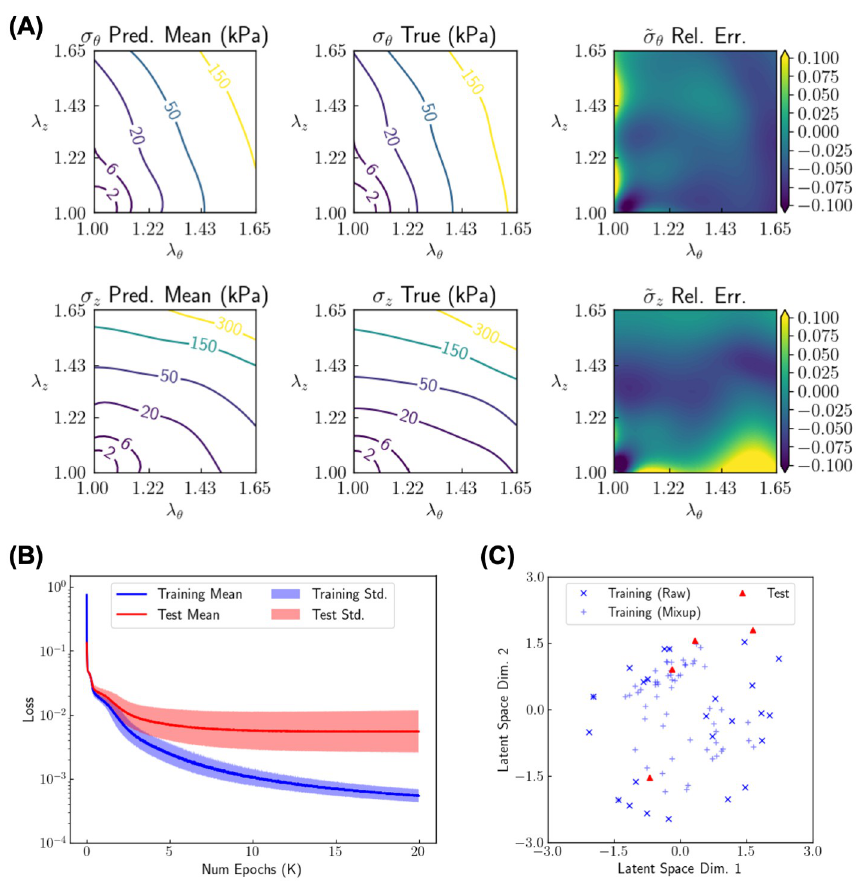
Fig 4. Results of G2 F net training. The dimension of sample feature is d η = 2. (A) Reconstruction of the stress-stretch relationship ( σ and σ as functions of λ and λ ) for a typical test sample averaged over model predictions across z θ z θ random seeds. Model prediction (output of the branch decoder and trunk net), ground truth value (input of the branch encoder), and their difference are shown. The predicted and true values of the stress are displayed by their respective physical values ( σ i where i = z , θ ; in kPa), while their difference is displayed as the relative (Rel.) error of the . (B) The reconstruction loss in the learning stage for training data and test data over all random normalized stress ~ s i seeds, all training/testing samples. Both the mean value and the standard deviation (Std.) are shown. (C) Visualization of the latent space of sample information with dimension (Dim.) d η = 2 for a typical train-test